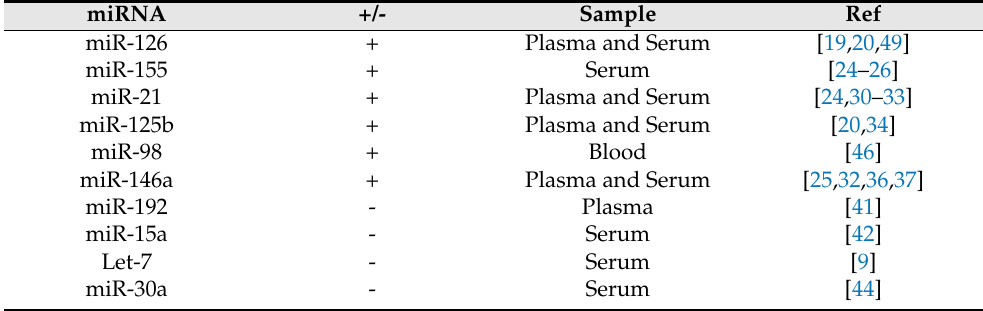
Table 2. miRNAs studied in the blood that can serve as a diagnostic panel.